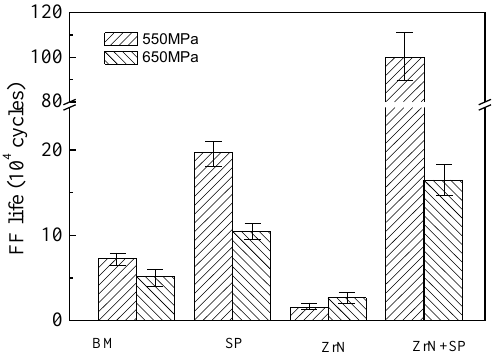
Figure 17. FF life of Ti6Al4V alloy with different modifications.